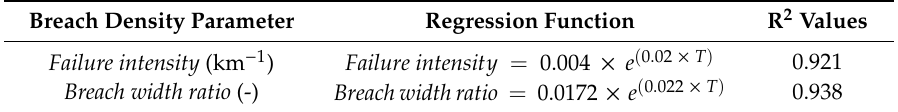
Table 4. Regression functions and R 2 -values for the breach density parameters and return periods.